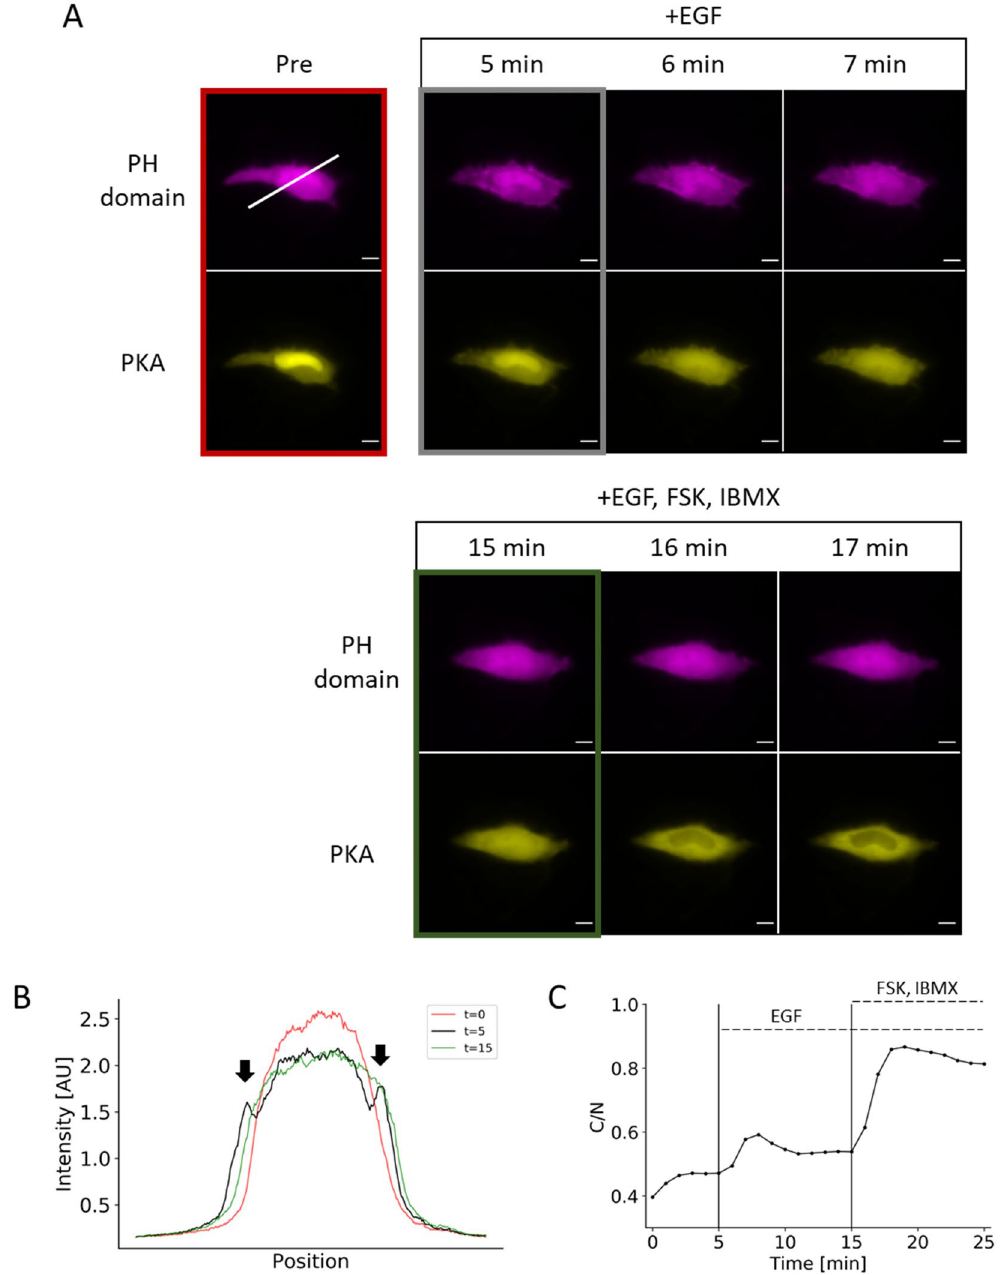
Figure 5. Duplex monitoring of PIP 3 and PKA in a single cell. ( A ) Representative images show PIP 3 accumulation (as indicated by translocation of PH domain) and PKA activity in a single cell after EGF treatment followed by PKA activation. ( B ) Line-scan of the image in Fig. 4A (white line) shows the transient appearance of enriched fluorescent signal at the plasma membrane (arrows). ( C ) Response profile shows the normalized signal change that results from EGF stimulation followed by a saturation of the reporter response with forskolin and IBMX cocktail. Data points represent measurement from a single cell. Scale bar represents 10 µ